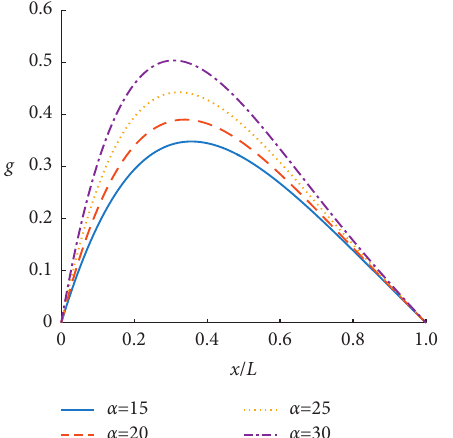
Figure 12: Influence of the parameter α on the equivalent couple amplification factor at different locations of the beam.